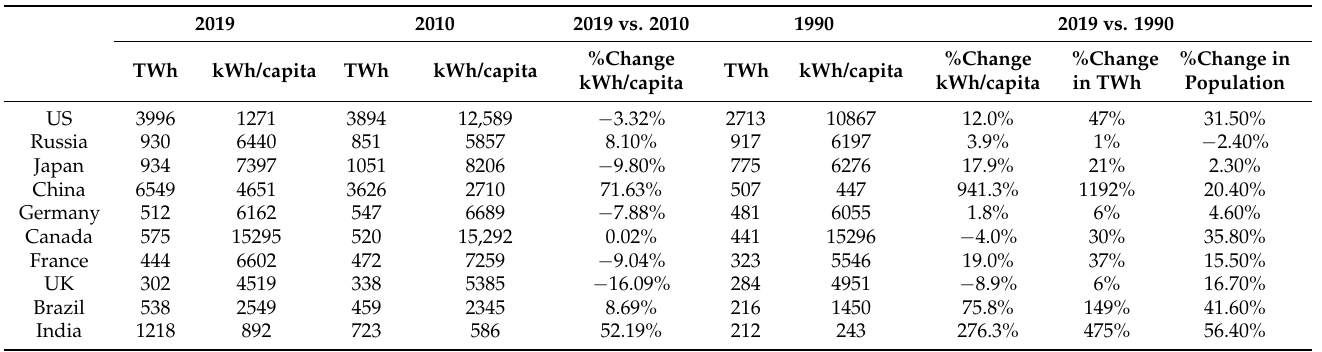
Table 1. Electricity Consumption 1990, 2010, 2019 for selected